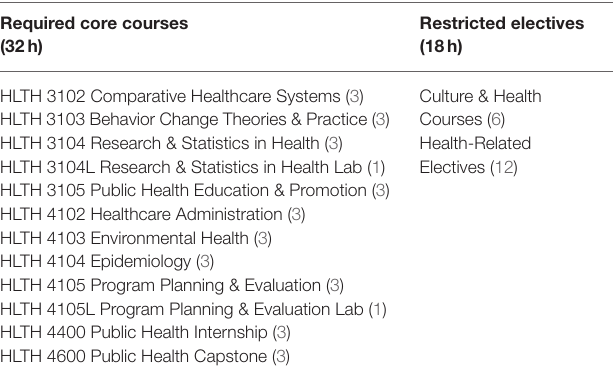
TABLE 1 | BSPH program core curriculum and elective requirements (credit hours). Required core courses